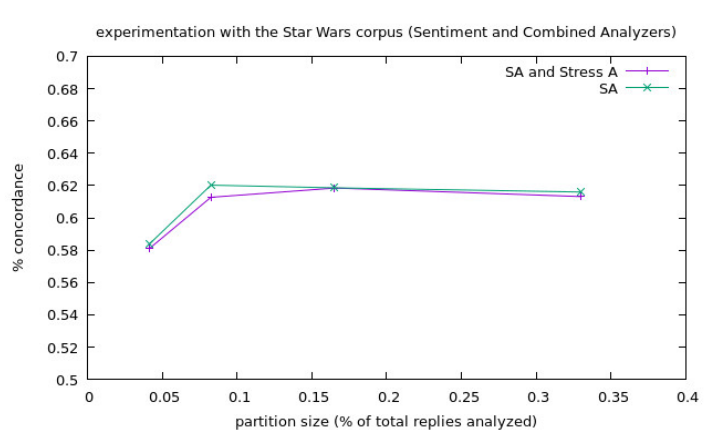
Figure 4. Results of the experiments with the corpora Star Wars for the Sentiment Analyzer and the Combined Analyzer.